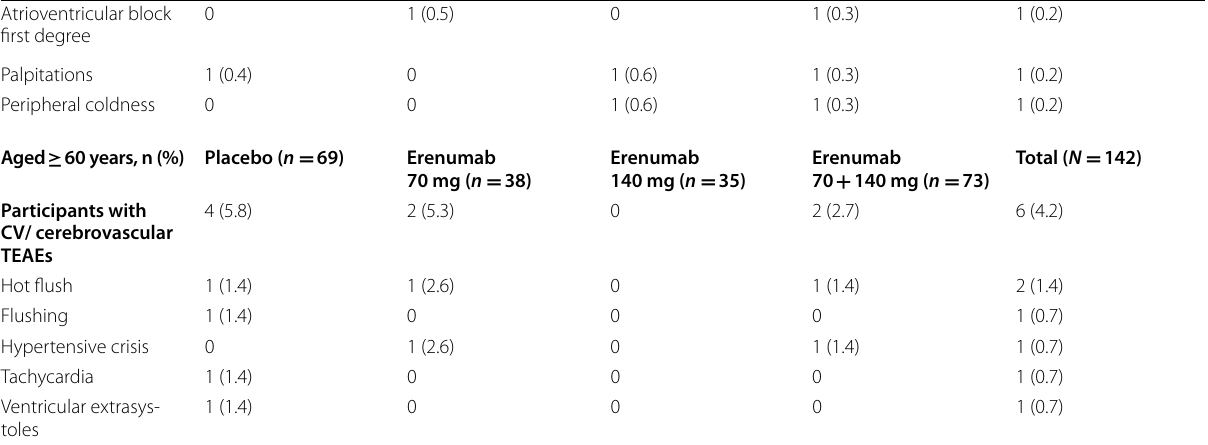
Data pooled from phase 2 CM, STRIVE, ARISE, LIBERTY, and EMPOwER studies (safety analysis set). The table contains AEs with onset date within 91 days from the first administration of erenumab. % n/N 100 = × The table contains AEs with onset date within 91 days from the first administration of the study drug. AEs are presented at the dose level at which the event occurred, so individuals who received erenumab at more than 1 dose level during the study were counted in both dose levels. Therefore, the total erenumab column may not be the sum of the individuals included in each of the individual dose levels Abbreviations: AE Adverse event, CM Chronic migraine, CV Cardiovascular, N Number of individuals exposed to the given dose level, n number of individuals reporting at least 1 occurrence of an AE in that class within 91 days from the first administration, SAE Serious AE, TEAE Treatment-emergent AE